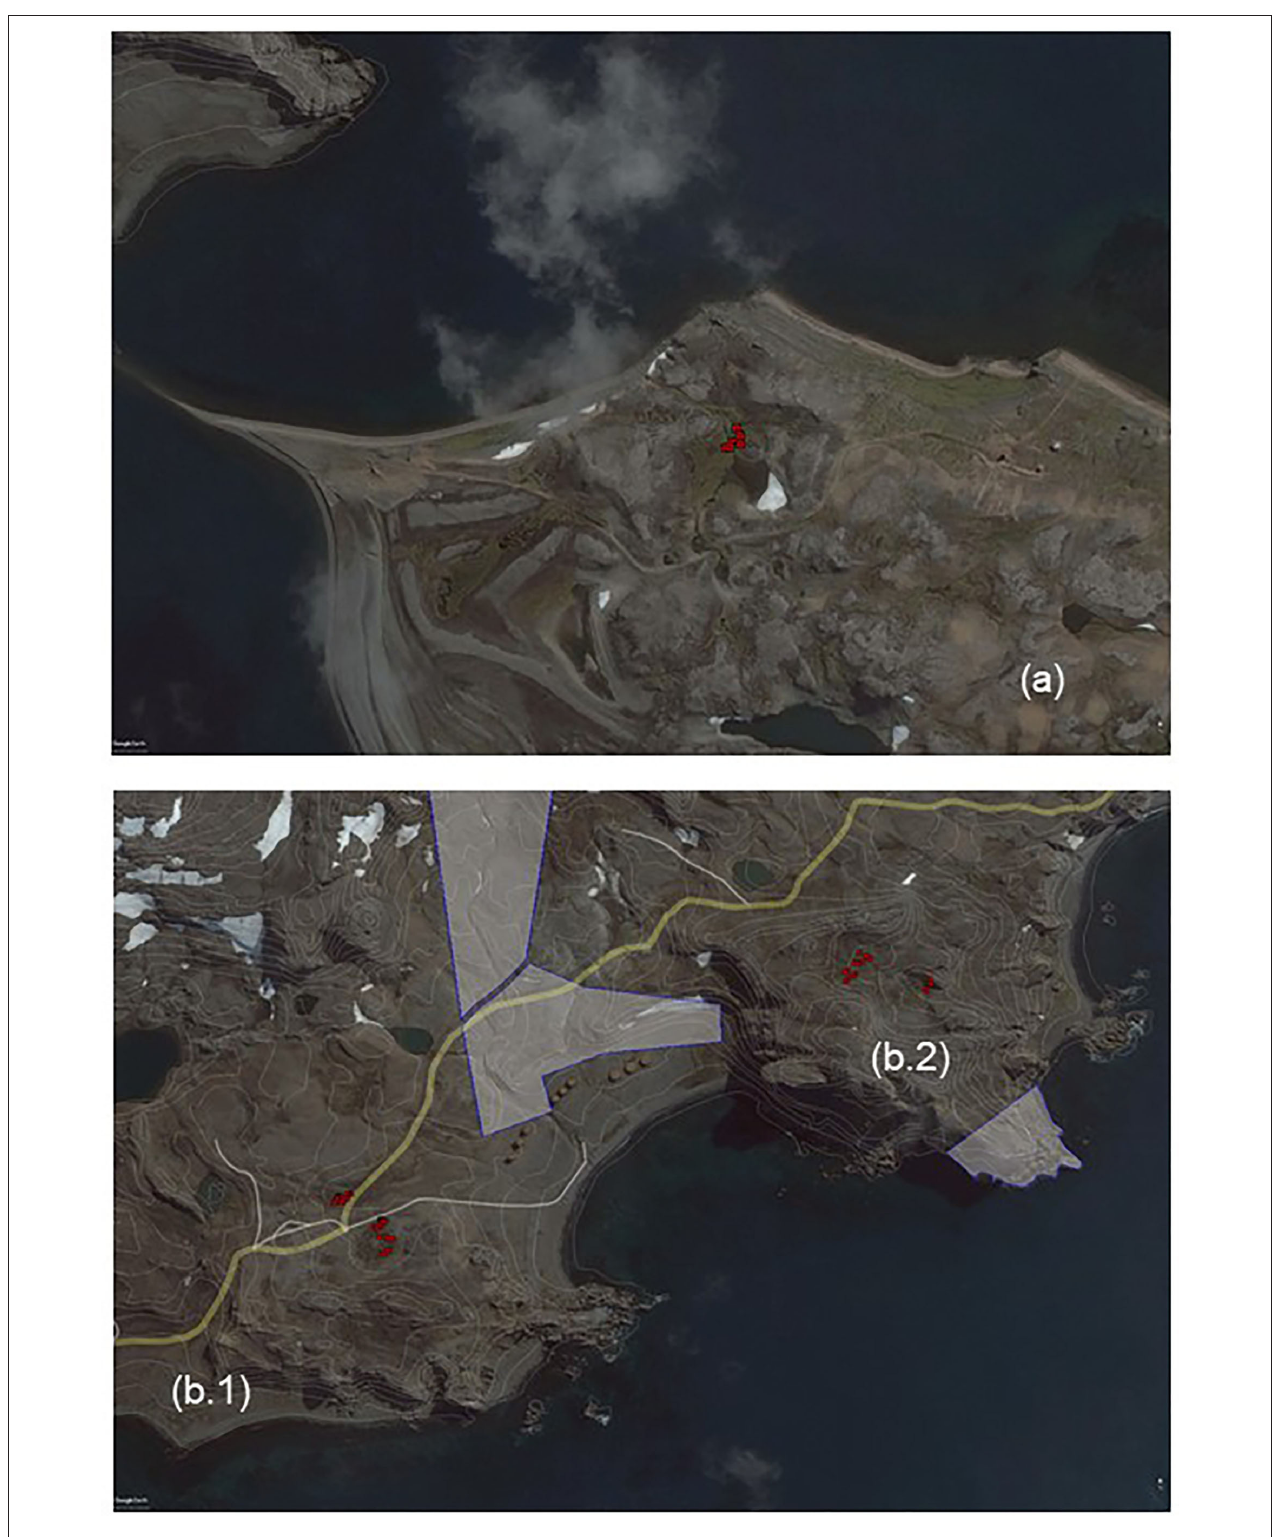
FIGURE 2 | Maps of spatial distribution and location of sampling sites groups in Fildes Peninsula, Maritime Antarctica. Sampling is depicted by red circles. To determine the origin of colonization after fragmentation due to vehicle transit and human trampling (a) Ardley Peninsula and (b.1) Suffield Point. To assess the importance of the runoffs in forming subpopulations (b.2) Suffield